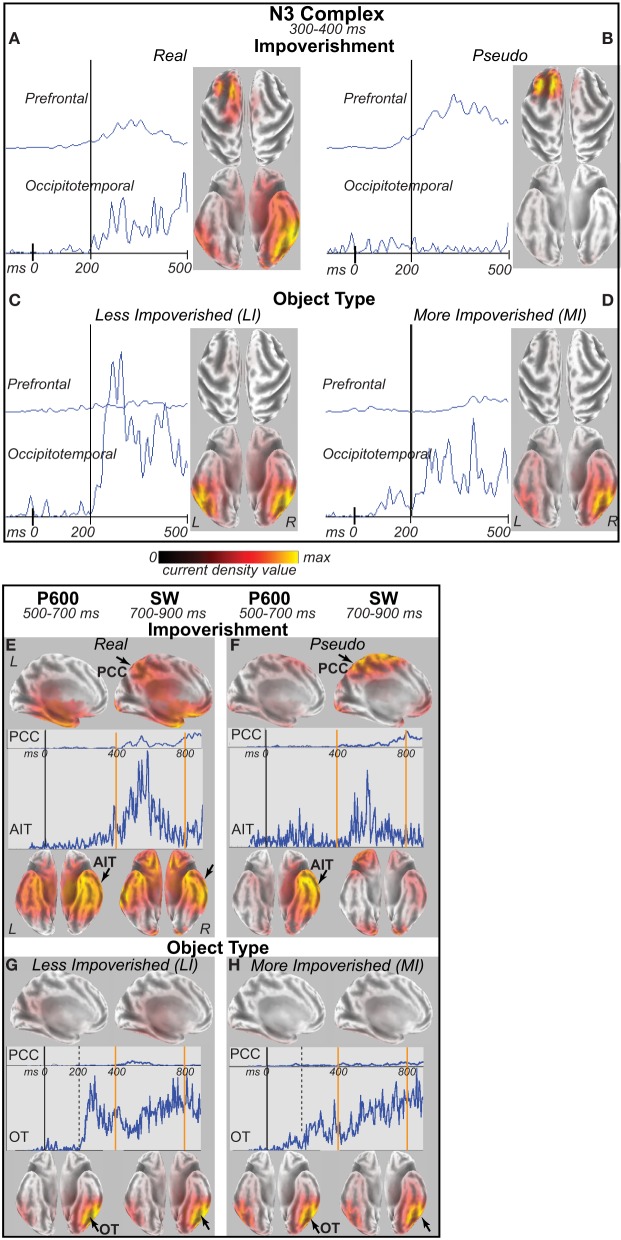
The sLORETA maps show estimated sources of the difference waves (Figure 7) between two conditions (impoverishment = MI minus LI; type = pseudo minus real) in the grand average ERPs. Maps shown superimposed on an inflated, canonical MNI152 (Colin) brain. Dark areas are sulci; light areas are gyri. L, left hemisphere; R, right hemisphere. Each brain shows standardized cortical current density distributions, and source activity reflects the location of differential source activity between conditions but not the direction of effects. Scale uses hot colors (red, yellow) for maximal current density value differences. (A–D)
N3 Sources. sLORETA maps shown for the N3 from 300 to 400 ms on dorsal (top) and ventral (bottom) cortical surfaces. Estimated intracranial ERPs plotted on the left for prefrontal (MNI x y z coordinates −15 20 65) and occipitotemporal sources (55 −45 –25) between −100 and 500 ms. (A)
N3 impoverishment sources for real objects. Occipitotemporal sources: inferior (BA 20, 60 −40 −20; BA 37, 55 −45 −25) and middle temporal (BA 21, 65 −35 −15; BA 20, 55 −40 −15), fusiform (BA 37, 50 −50 −25; BA 20, 55 −35 −25; BA 19, 45 −70 −20; BA 36, 45 −40 −25), middle occipital (BA 19, 50 −70 −15), lingual (BA 18, 15 −85 −20), and parahippocampal (BA 36, 40 −30 −25) gyri. Prefrontal sources: superior (BA 6, −15 20 65; BA 8, −25 30 55), middle (BA 6, −25 20 60; BA 9, −35 40 40), and inferior frontal (BA 47, 20 25 −20) gyri. (B)
N3 impoverishment sources for pseudo objects. Same prefrontal sources as for real objects. (C)
N3 object type sources for LI. Occipitotemporal sources: fusiform (BA 37, 55 −60 −20, −50 −60 −25; BA 36, 45 −40 −30; BA 19, −50 −70 −20), inferior temporal (BA 20, 50 −55 −20; −60 −55 −20), middle temporal (BA 37, 55 −55 −15, −55 −65 −15; BA 21, 65 −50 −10), middle occipital (BA 37, 50 −65 −15, −50 −65 −15; BA 19, 50 −75 −15), parahippocampal (BA 19, 35 −45 −10) gyri. (D)
N3 object type sources for MI. Same occipitotemporal sources as for LI. (E–H)
P600 and slow wave (SW) Sources. sLORETA maps shown for left medial (top) and ventral (bottom) cortical surfaces. OT, occipitotemporal cortex; AIT, anterior inferior temporal cortex; PCC, posterior cingulate cortex, including precuneus and cuneus. Estimated intracranial ERPs plotted for the voxel showing maximum impoverished-real-object effects from 300 to 400 ms (same as later) in OT (55, −45, −25), 500 to 700 ms in AIT (25, 0 −45), and 700 to 900 ms in PCC (0 −55, 65). (E)
Late impoverishment sources for real objects. AIT sources (maximum BA 20, 25–30 −5 −45) occurred from 450 to 700 ms when the P600 peaks: middle (BA 21, 65 −30 −20) and inferior temporal (BA 20, 60 −35 −20), fusiform (BA 20, 55 −35 −25), parahippocampal (BA 36, 35 −25 −30; BA 35, 30 −25 −25), and other limbic structures (BA 20, 25 0 −45; BA 38, 25 5 −45; BA 36, 25 −5 −40; BA 28, 25 −10 −35). From 500 to 700 ms, limbic lobe dominated (BA 20/38, 25 0 −45), including parahippocampal gyrus (BA 35, 25 −15, −30). From 700 to 900 ms, impoverishment effects in anterotemporal cortex continued and appeared in medial posterior cortex around cingulate (BA 25, 0 5 −10; BA 31, −10 −45 40), cuneus (BA 17, 5 −100 −5), and precuneus (BA 7, 5 −60 65; −5 −50 50), and occipital extrastriate regions (BA 18, 0 −95 −15). The SW effect in PCC is active after 700 ms. (F)
Late impoverishment sources for pseudo objects. P600-like wave in AIT and SW in PCC shown. (G)
Late object type sources for LI, and (H)
for MI: Occipitotemporal cortex only.